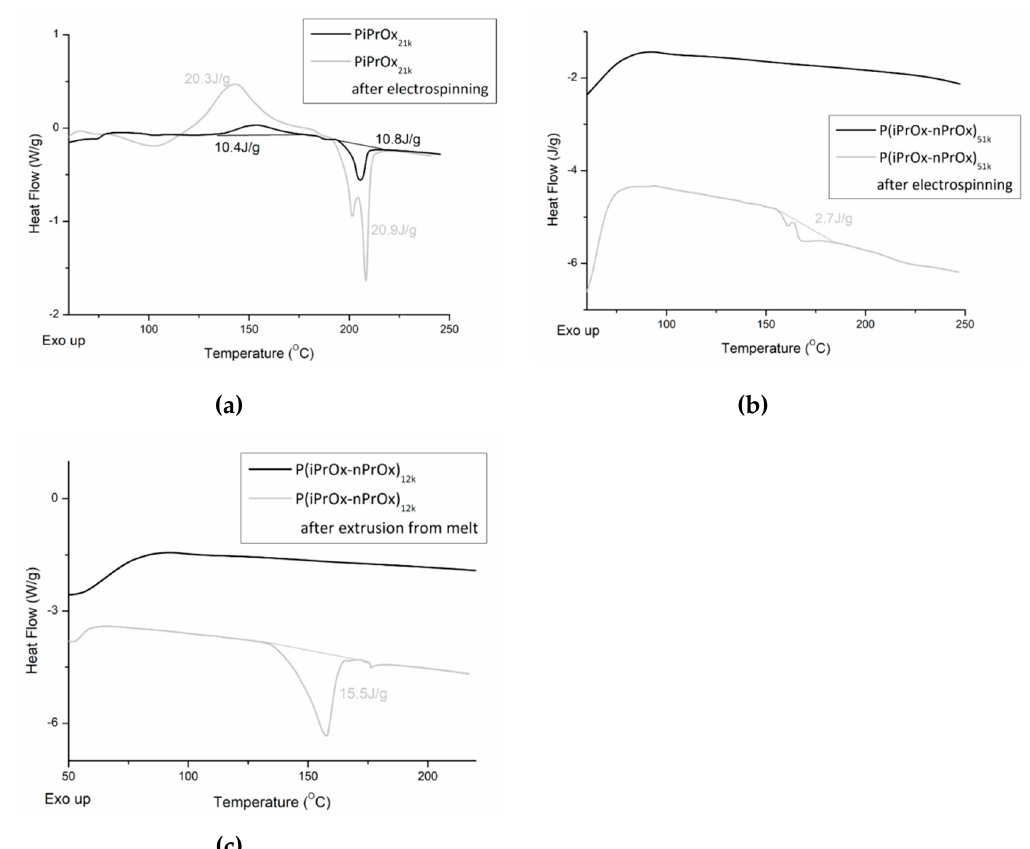
Figure 9. DSC traces of ( a ) PiPrOx 21k and ( b ) P(iPrOx–nPrOx) 51k before and after electrospinning and DSC traces of ( c ) P(iPrOx–nPrOx) 12k before and after extrusion from melt.